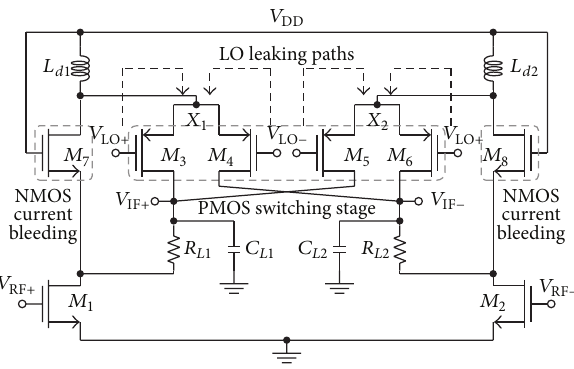
Figure 2: A schematic view of the proposed